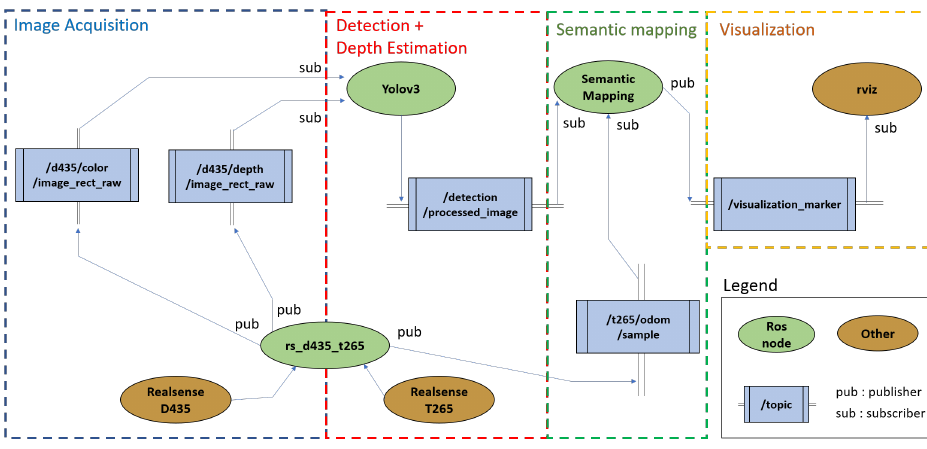
Figure 3. ROS Software